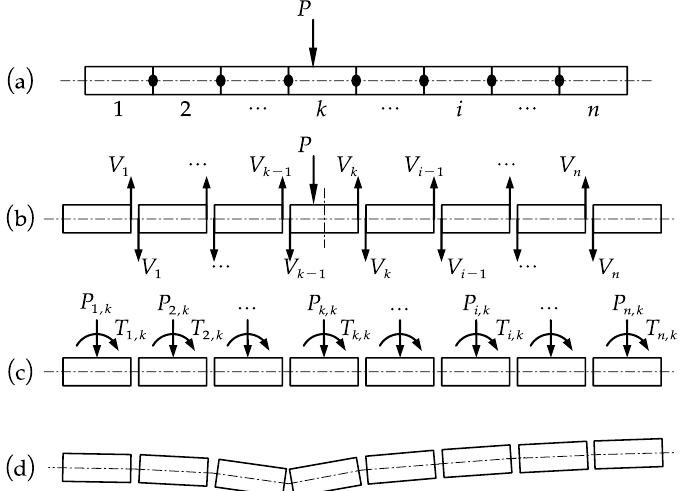
centerline of the slab k .